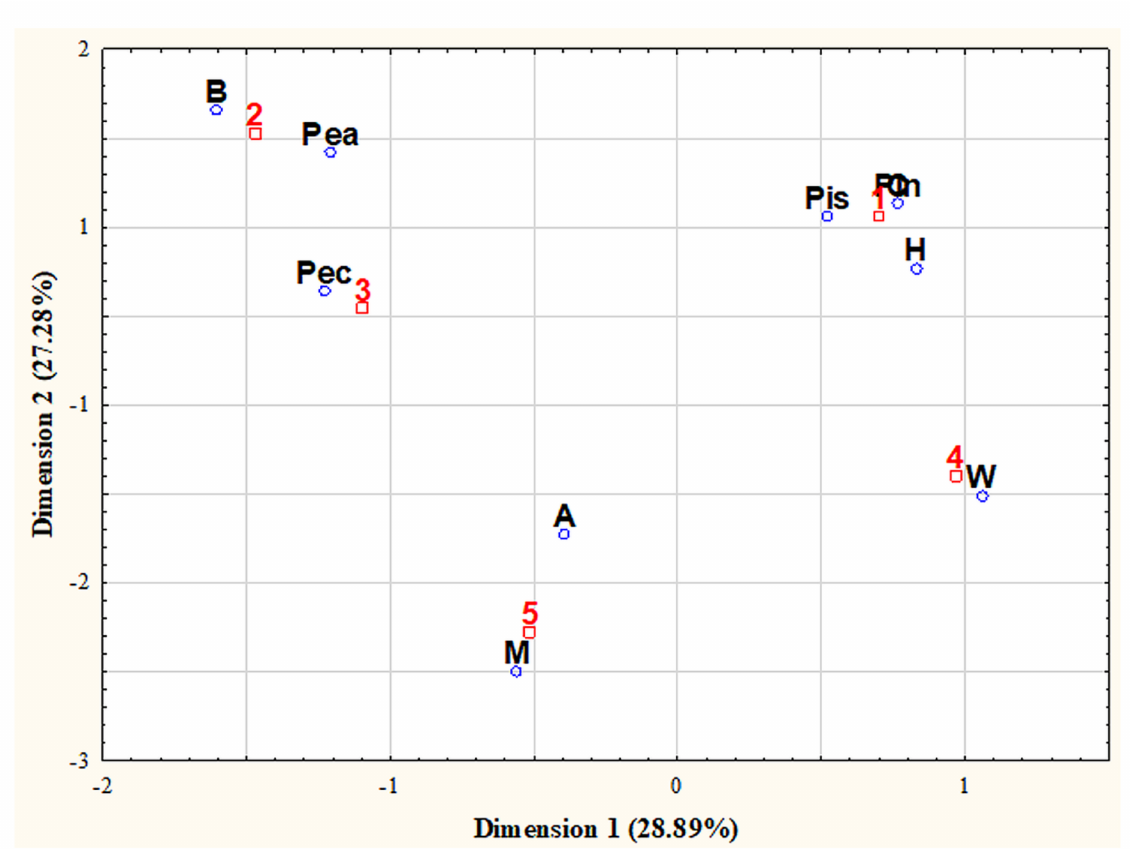
Figure 4. Two—dimensional graph for the tested nuts. A—almonds; B—Brazil nuts; C—cashews; H—hazelnuts; M— macadamia; Pea—peanuts; Pec—pecans; Pin—pine; Pis—pistachios; W—walnuts; 1—Asia; 2—South America; 3—North America; 4—Europe;